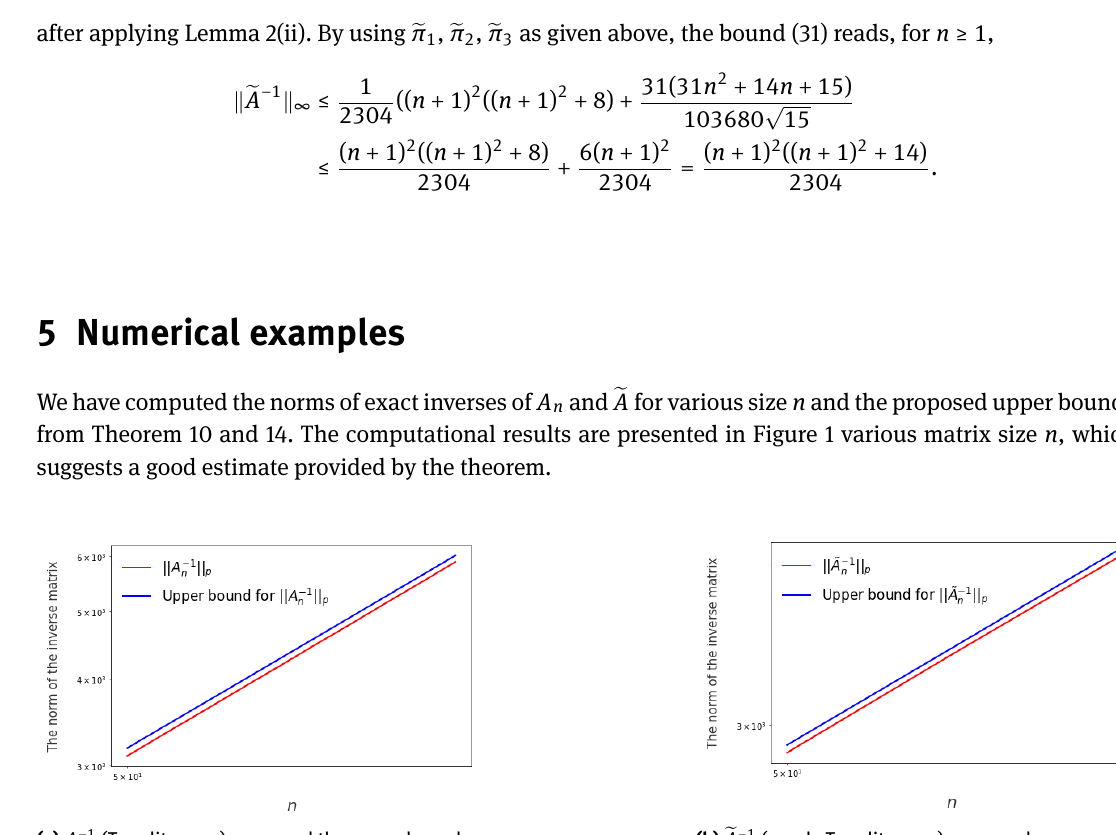
Figure 1: Evaluation of norm of inverse of matrices and bound in the log scale.